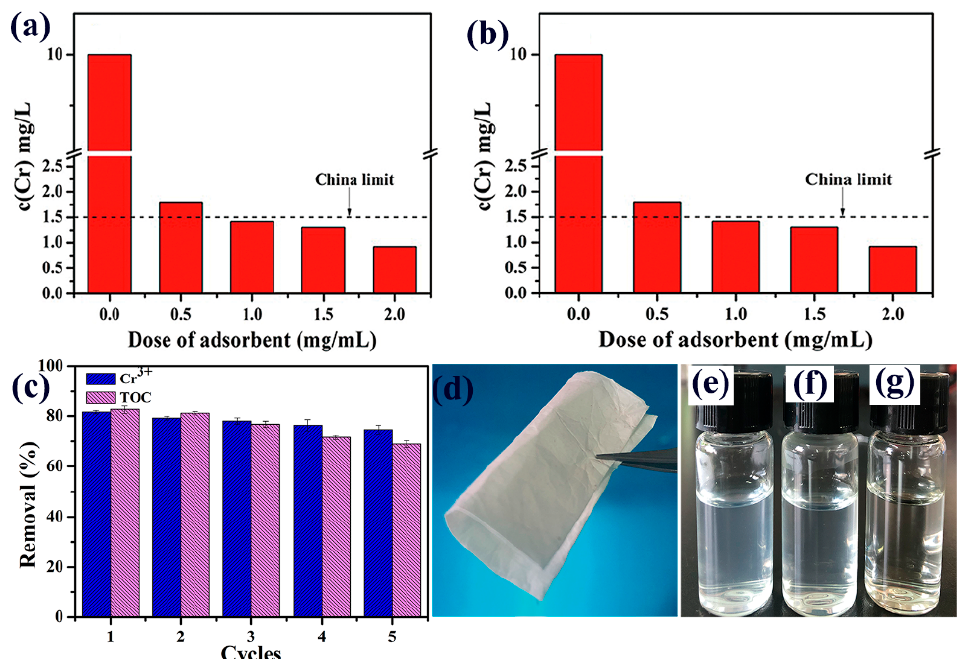
Figure 7. Effects of adsorbent dosage ( a ) and initial concentration ( b ) for Cr(III) removal. ( c ) Regeneration cycle study of PAN–TA-3 NFs; digital photograph of PAN–TA-3 NFs ( d ), Cr–collagen complex solution before ( e ) and after adsorption by PAN NFs ( f ) and PAN–TA-3 NFs ( g ) for over 120